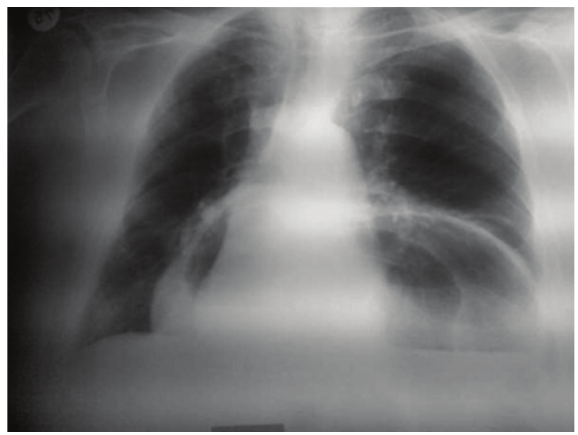
Figure 2: Erect abdominal X-ray reveals a large hiatal hernia with a greatly distended gastric bubble and distended bowel